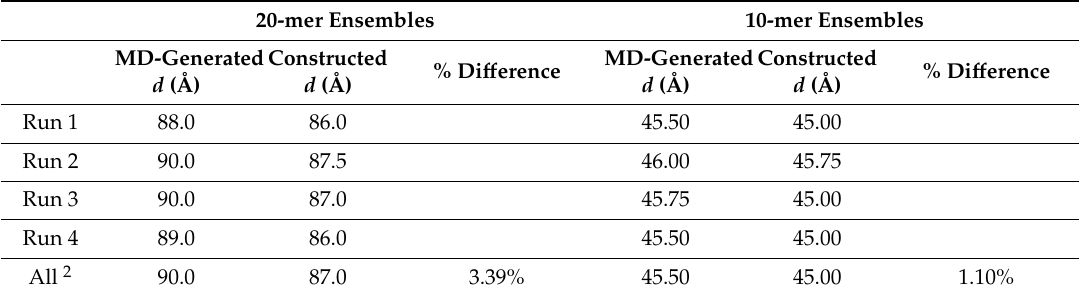
Figure 14. End-to-end distance probability distribution of MD-generated nonsulfated keratan 20-mer ensemble; each of the four runs includes 10,000 conformations; probabilities were calculated for end-to-end distances sorted into 0.5 Å bins. Table 5. Most Probable End-to-End Distances ( d ) in MD-Generated and Constructed Nonsulfated Keratan Ensembles 1